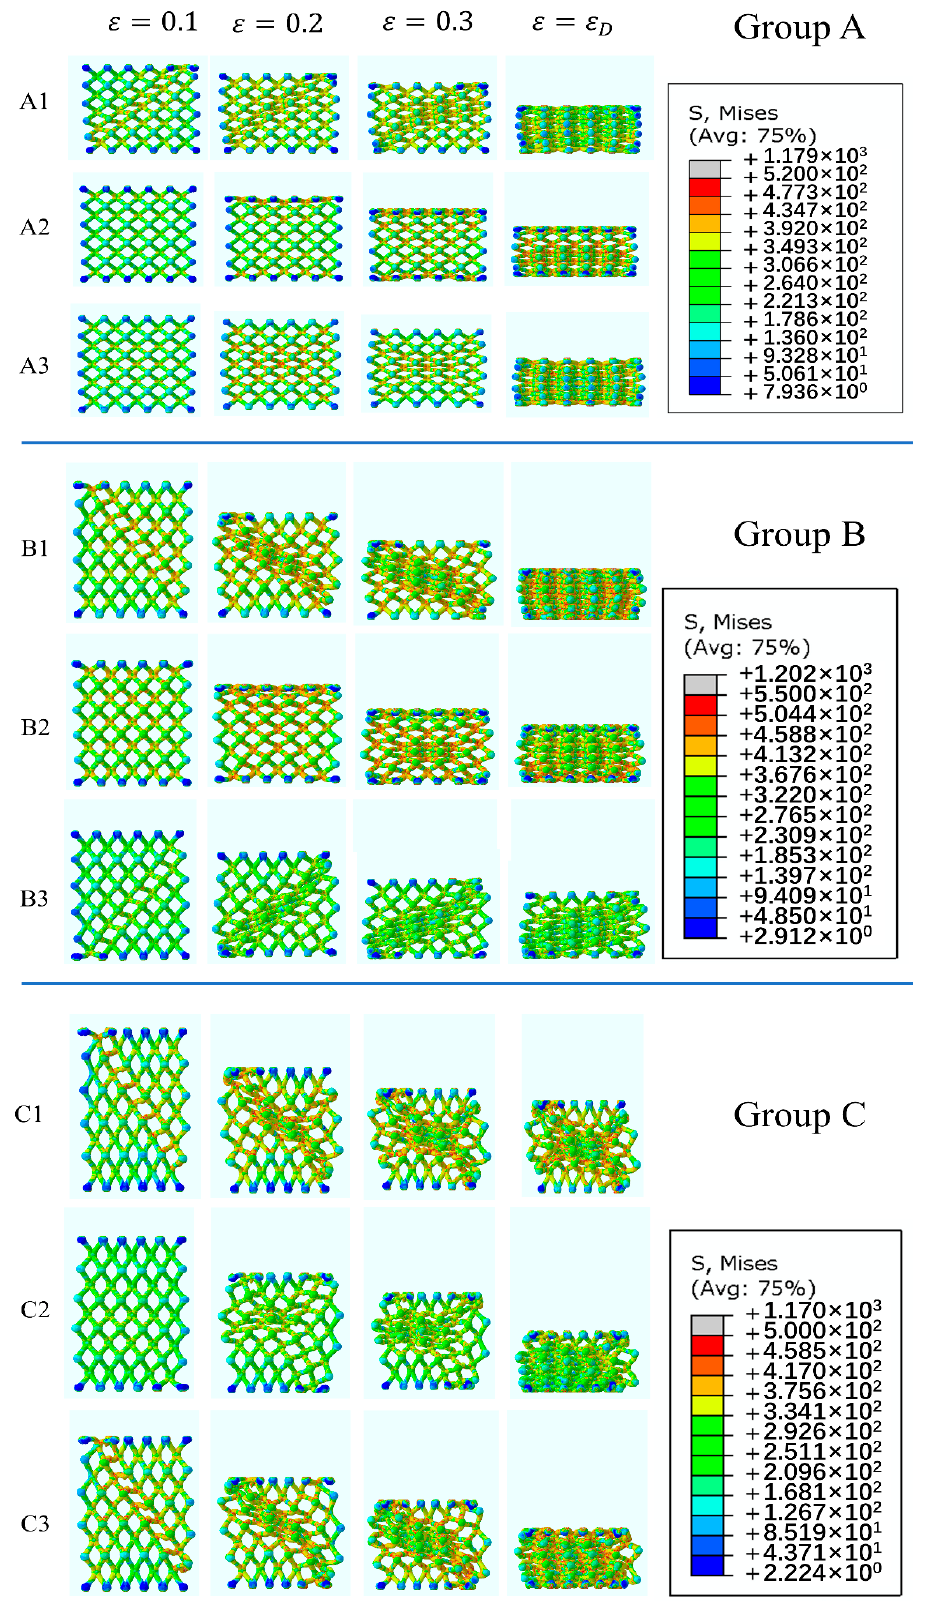
Figure 6. Mises stress distribution diagrams of EP lattice structures in Group A, B and C.